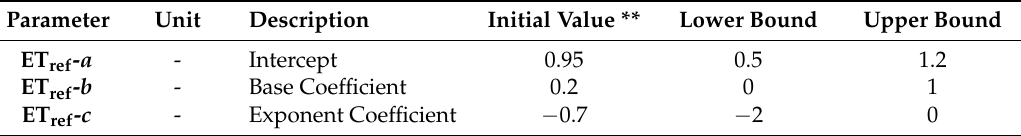
Table 2. Setup of newly introduced parameters for dynamic ET ref scaling function for sensitivity analysis: parameter types, initial values, and